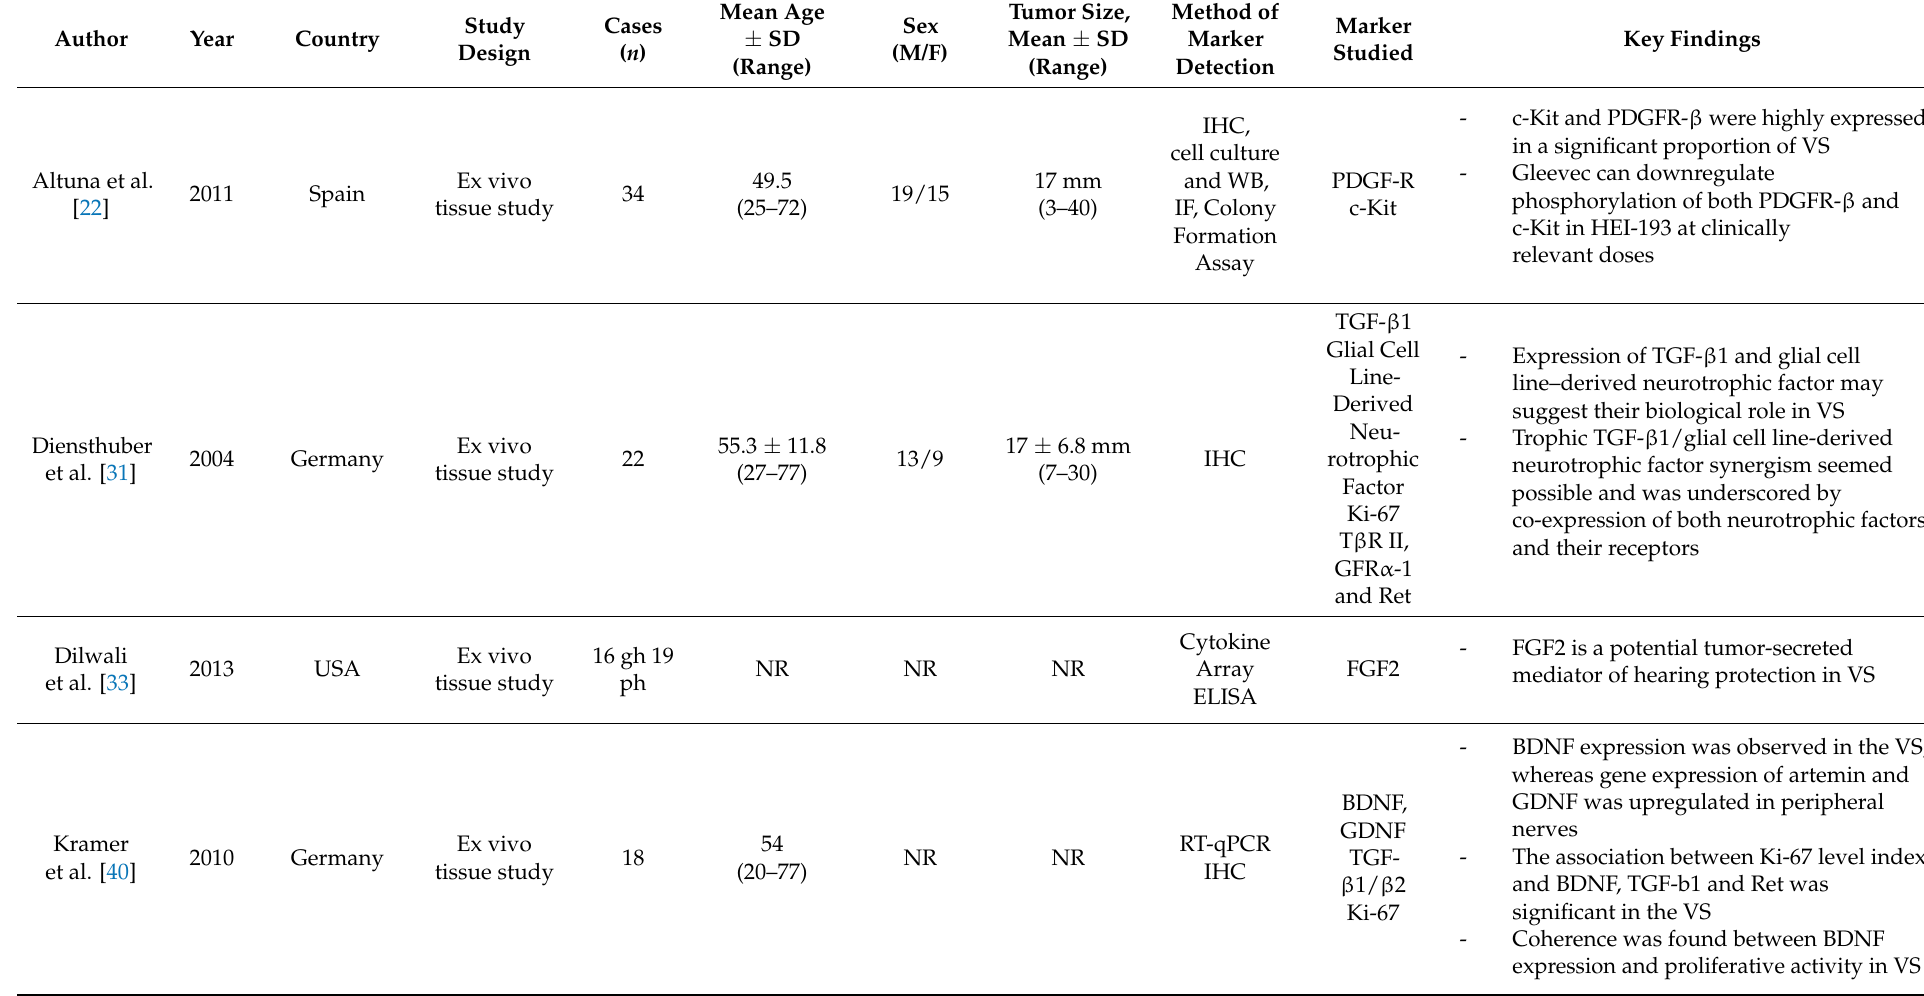
Table 4. Studies examining the role of growth factors in sporadic vestibular